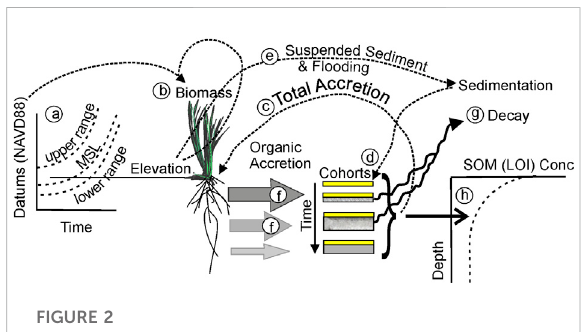
FIGURE 2 Schematic diagram of the dependencies and outputs of